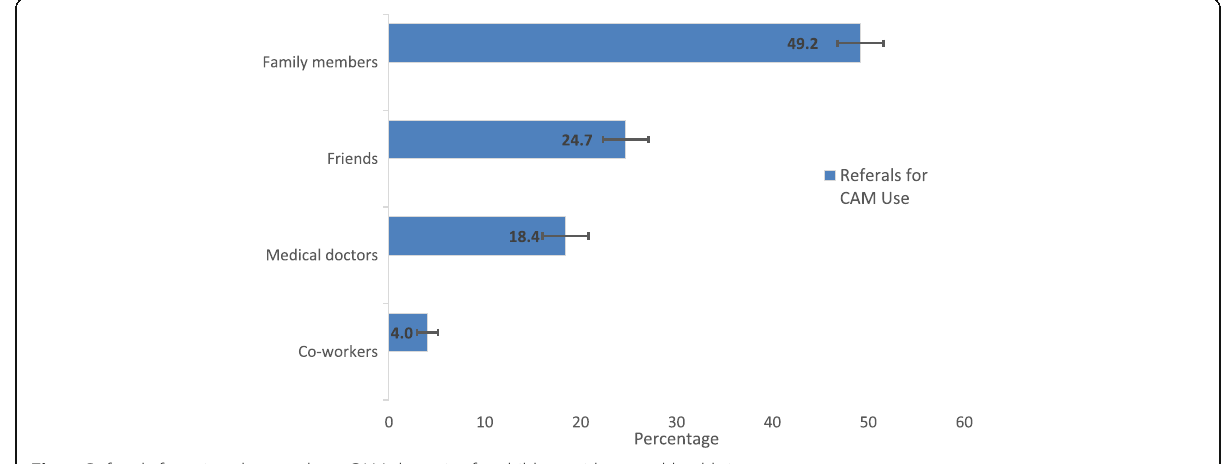
Fig. 5 Referrals for using the top three CAM therapies for children with mental health